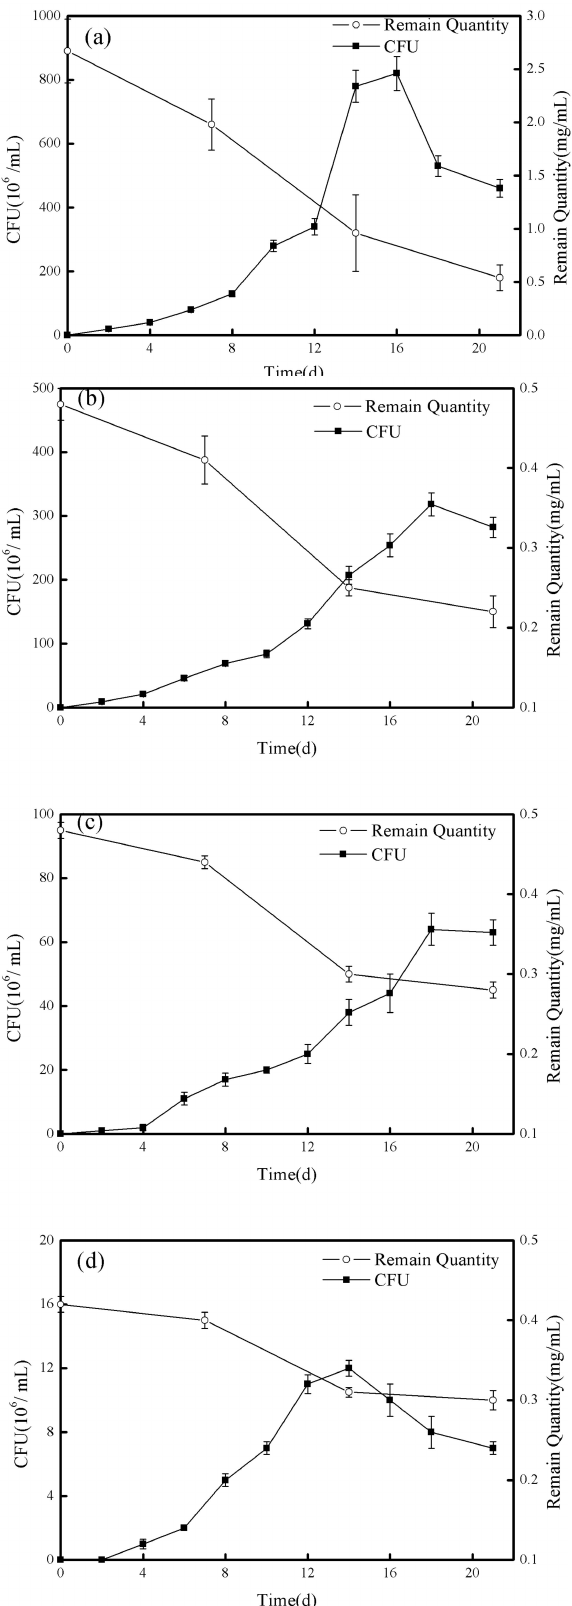
Figure 7. Growth of the strain on different n-alkanes as the sole carbon sources and its degradation of the alkanes ( a – d ) represented the case of n-alkanes C16, C24, C32, and C40,